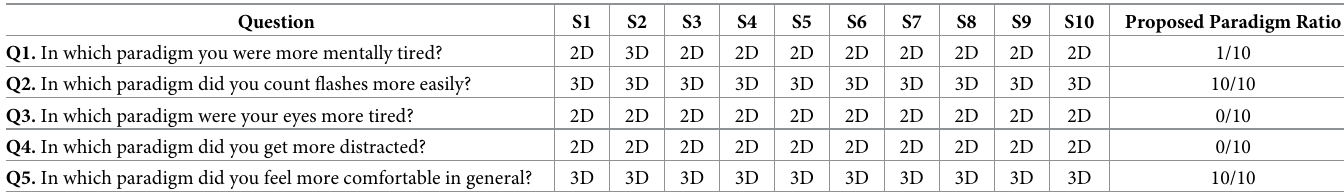
Table 5. Questionary and answers.